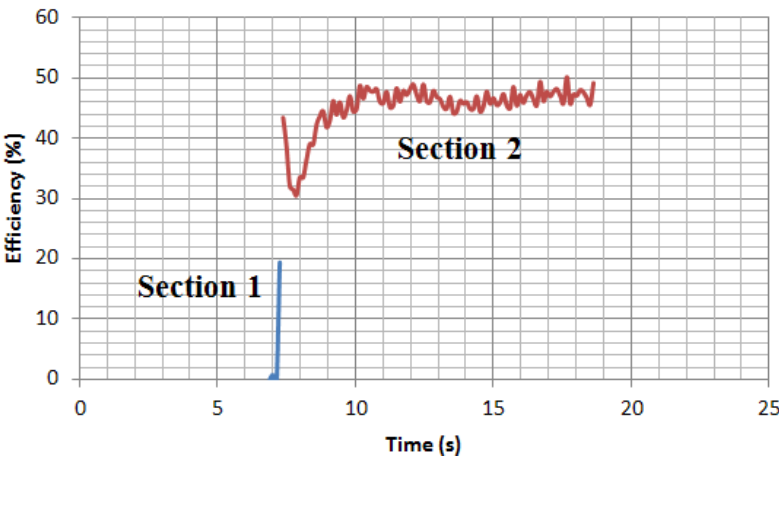
Figure 11. The efficiency of an air motor and a DC servo